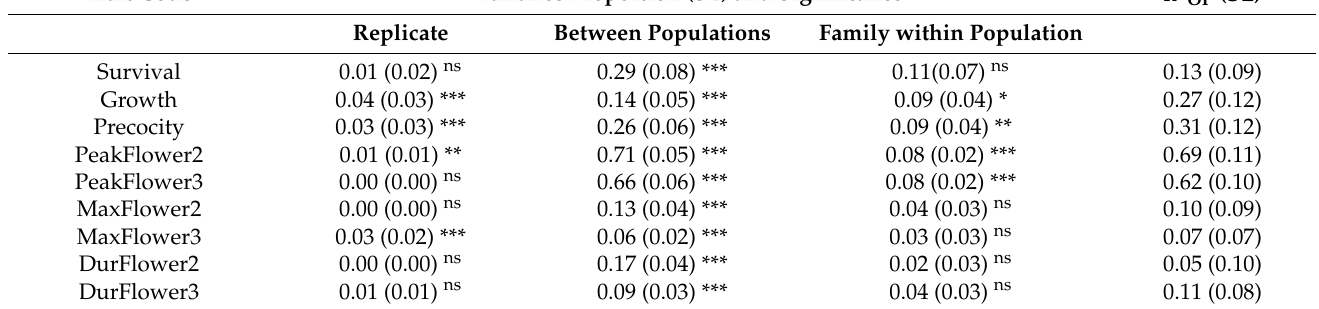
Table 2. The proportion of the total variation attributable to random replicate, population, and family within population effects, their significance, and within population narrow-sense heritability (h 2 OP ) for growth and reproductive traits of Leptospermum scoparium grown in a common garden (standard errors are indicated in